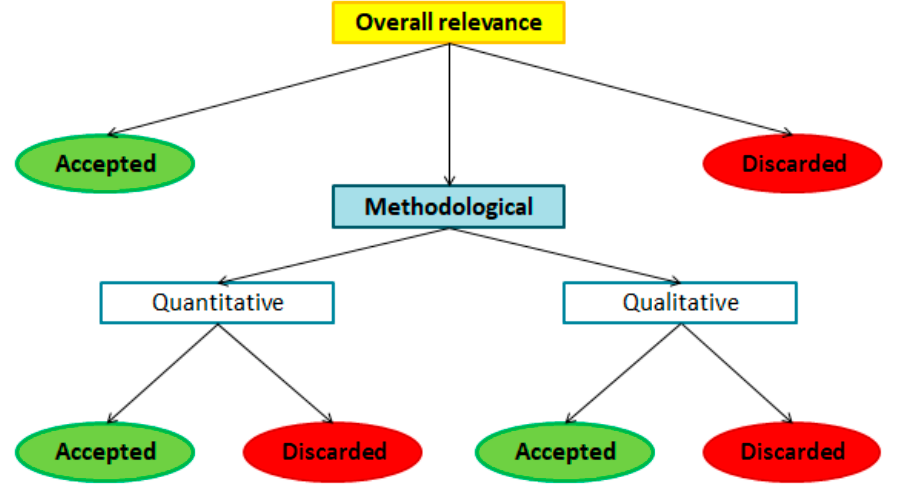
Figure 1. Graphic of the acceptance process of the papers.